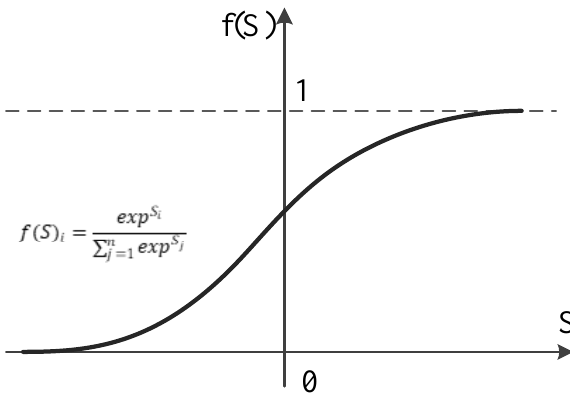
Figure 8. Activation function softmax.